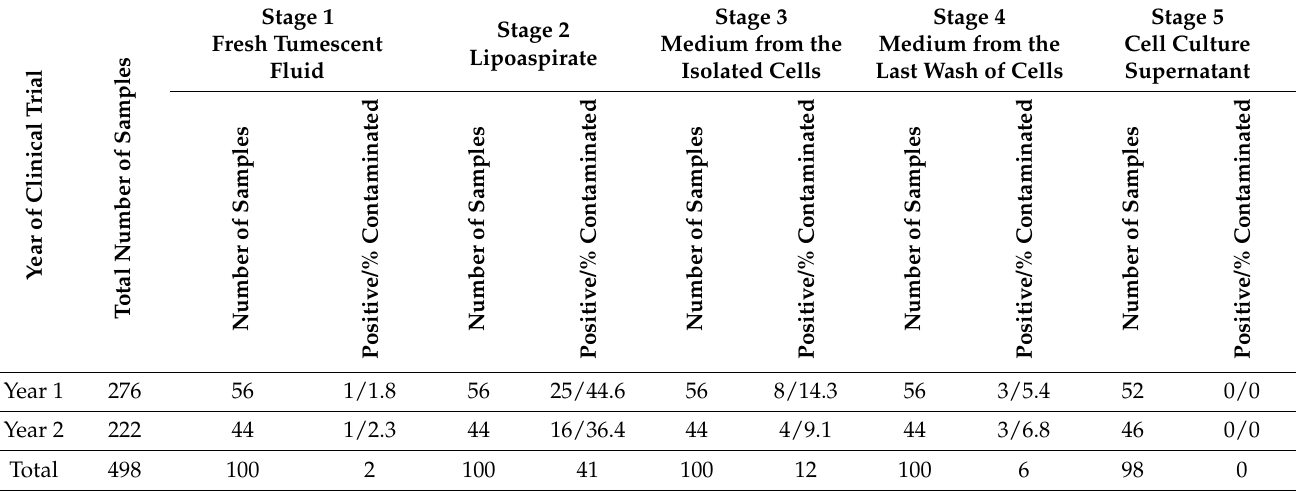
Table 1. Contamination of the processed material at subsequent stages—from harvesting of the adipose tissue to the primary cell culture—observation from a two-year clinical